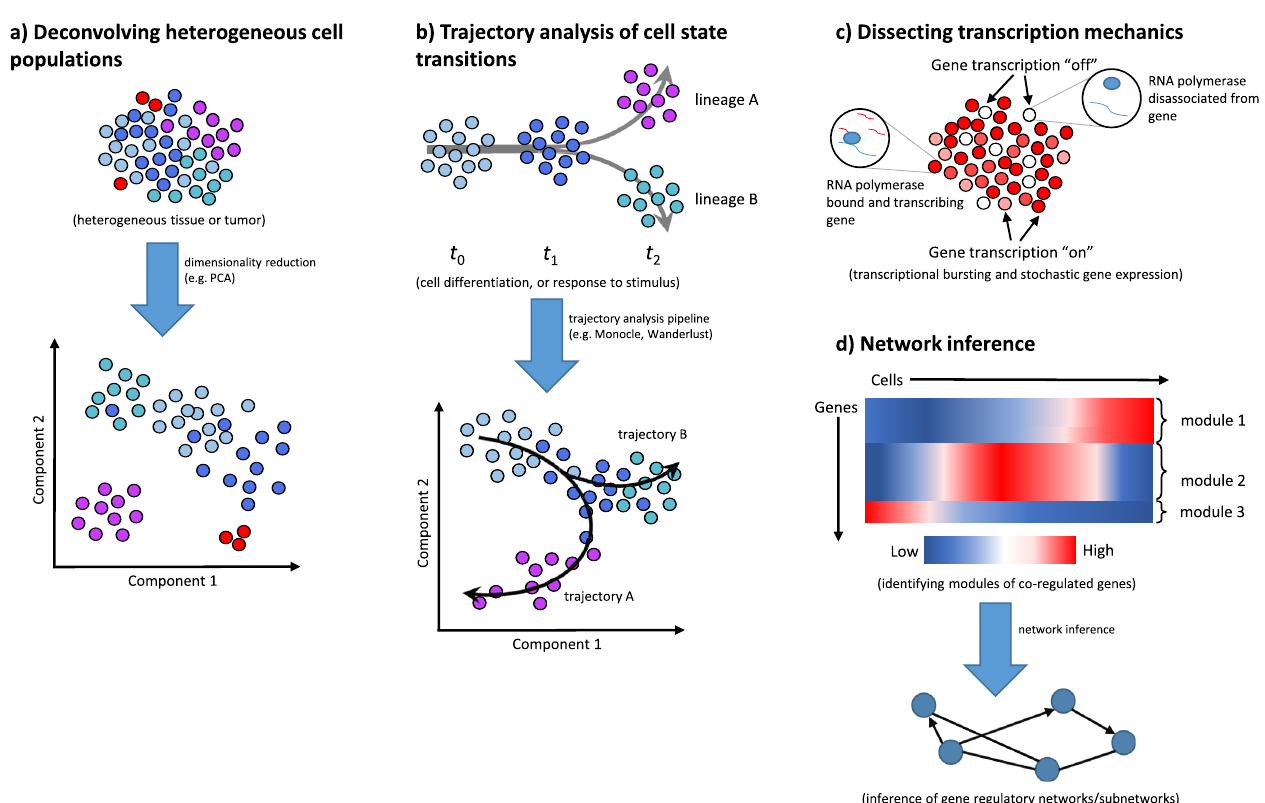
Figure 1. Common applications of single-cell RNA sequencing. ( a ) Deconvolving heterogeneous cell populations. Clustering by single-cell transcriptomic profiles can reveal population substructure and enable the identification of cell subtypes and rare cell species (e.g. red cells above). Clusters may be tight and well defined (purple, red) or diffuse (blue). ( b ) Trajectory analysis of cell state transitions. Single-cell RNA sequencing time-series data can be used to map cell developmental trajectories over the course of dynamic processes such as differentiation or signaling responses to an external stimulus. Some computational suites (e.g. Monocle 6 ) can also accommodate branching trajectories, enabling identification of lineage-specific gene expression and key genes that drive branching events. ( c ) Dissecting transcription mechanics. Genes’ expression profiles across many cells can be compared to study transcriptional bursting and to model the kinetics of stochastic gene expression. ( d ) Network inference. Genes can be clustered by expression profile to identify modules of putatively co-regulated genes, and gene-gene covariation relationships can be used to infer gene regulatory networks or